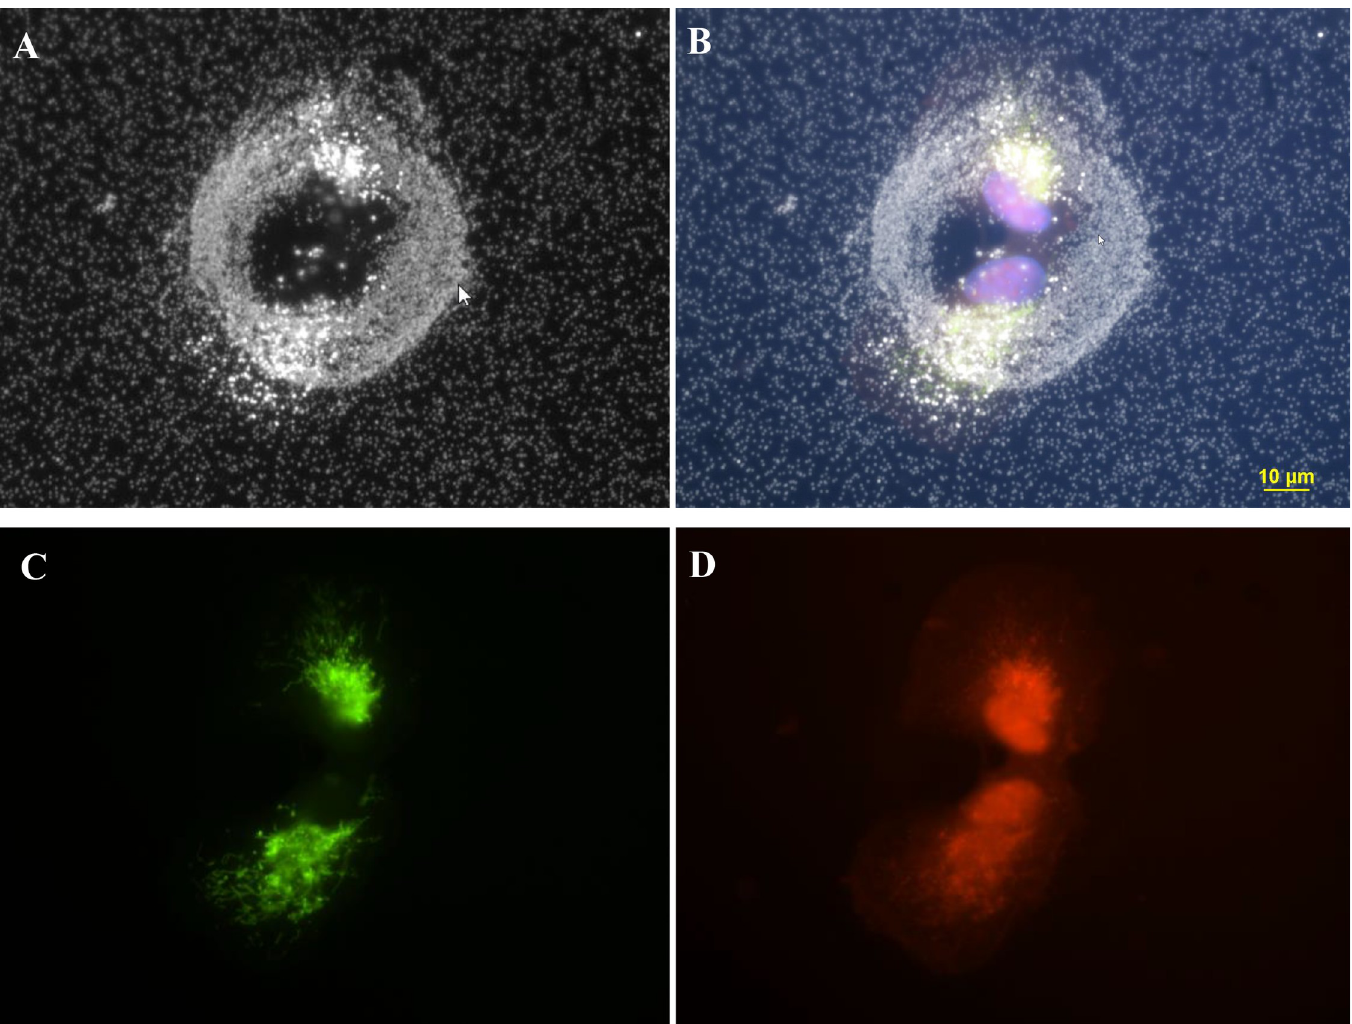
Fig 11. The four-panel figure of cell shown in Fig 2D was treated with 3ug/ml AgNP. Panel A. Darkfield image of a ring structure with 2 newly divided cells on top of ring structure. Panel B. Composite of individual dark field (A) and fluorescent images (C, D) were combined into a composite image (B). DAPI stained nuclei (blue) was added to the composite. Panel C. Cells transfected with Mito-GFP (green). Panel D. Cell stained with CellMask Orange plasma membrane stain. Magnification